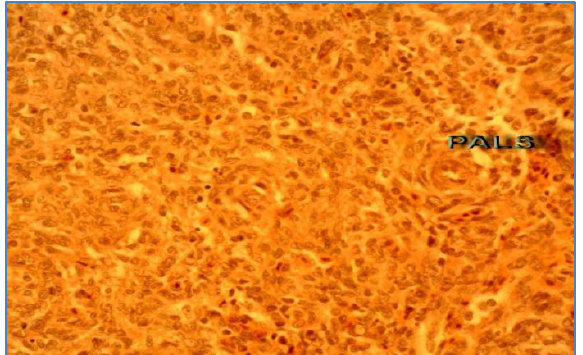
Figure, 4: At 1 day after hatching showing PALS, Masson Trichrome x400.